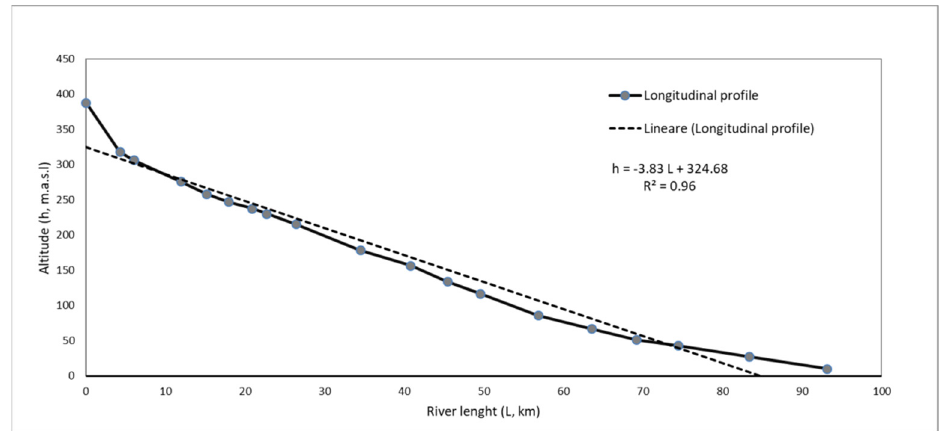
Figure 7. Longitudinal profile of the Dittaino River showing the main segments of the main path.